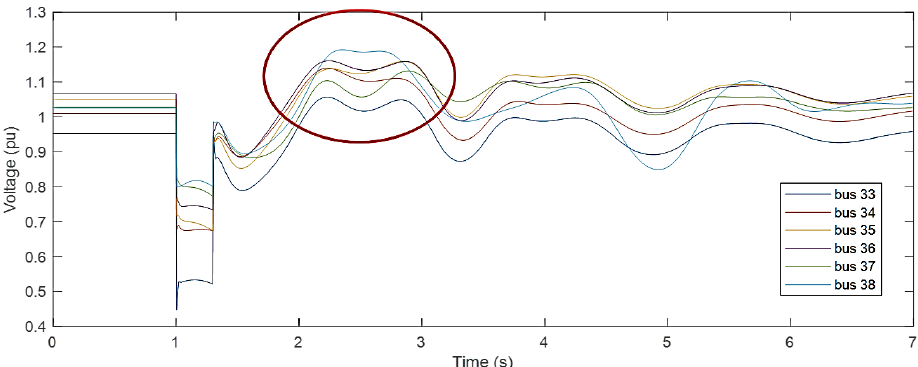
Energies 2021 , 14 , x FOR PEER REVIEW Figure 5. Voltage profiles of various buses during a 3-phase fault at bus 2. Figure 5. Voltage profiles of various buses during a 3-phase fault at bus 2.